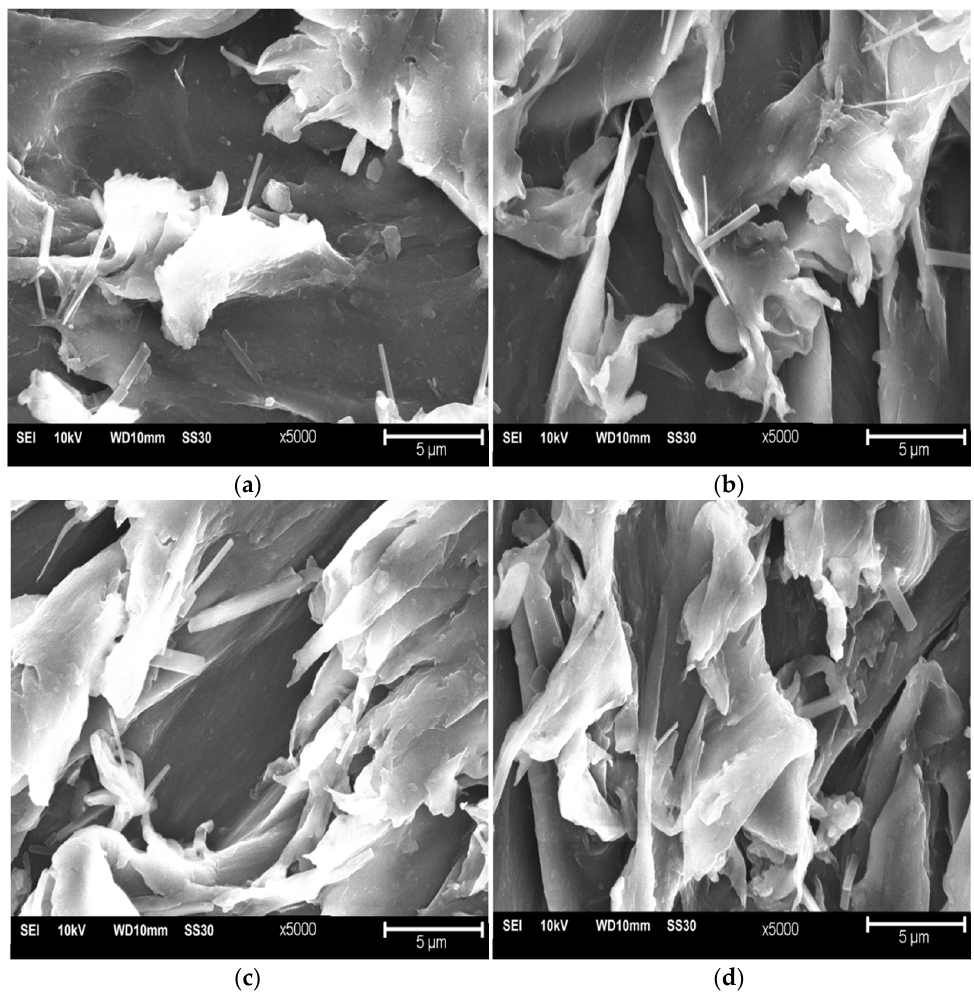
Figure 4. SEM images of surfaces ( a ) 90PLA, ( b ) 80PLA, ( c ) 70PLA, and ( d ) 60PLA at 5000 × magnification. PCL particles dispersed in a matrix of PLA largely formed a bond of PLA/PCL